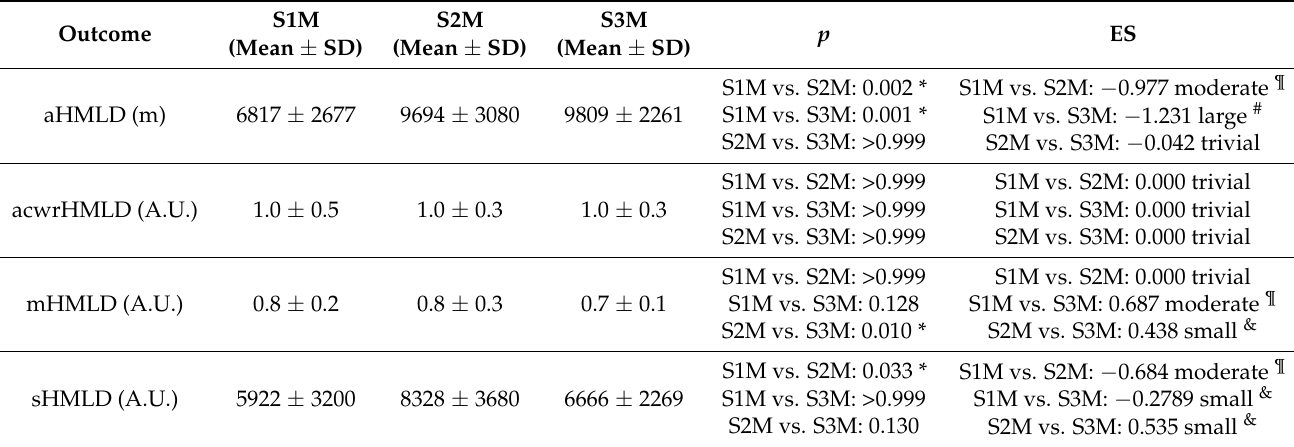
Table 2. Descriptive and inferential statistics (mean ± SD) of high metabolic load distances workload indices in different levels of participation in matches.